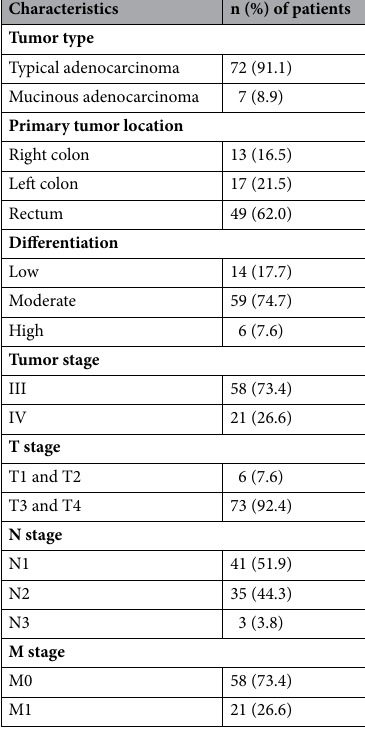
Table 1. Clinicopathologic characteristics. A TNM classification system 57 was used to define the tumor stage, T stage, N stage and M stage of the